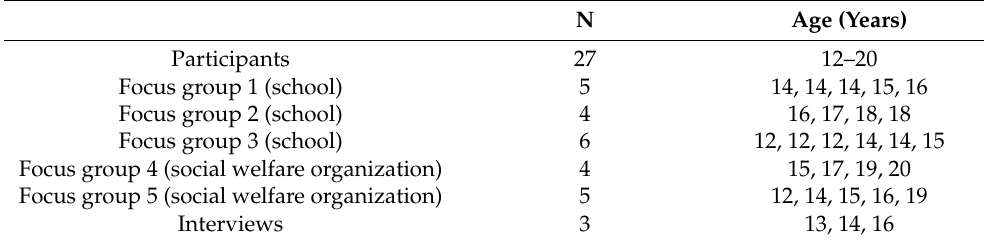
Table 1. Composition study sample per focus group and